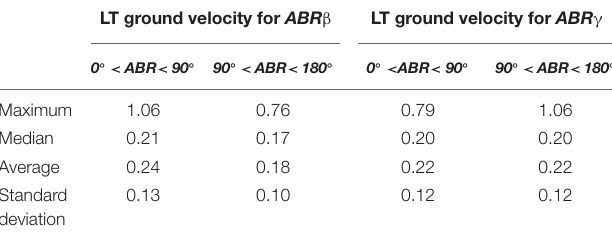
TABLE 2 | Descriptive statistics of loggerhead turtle (LT) ground velocity ( m · s − 1 ) in relation to ABR β and ABR γ . LT ground velocity for ABR